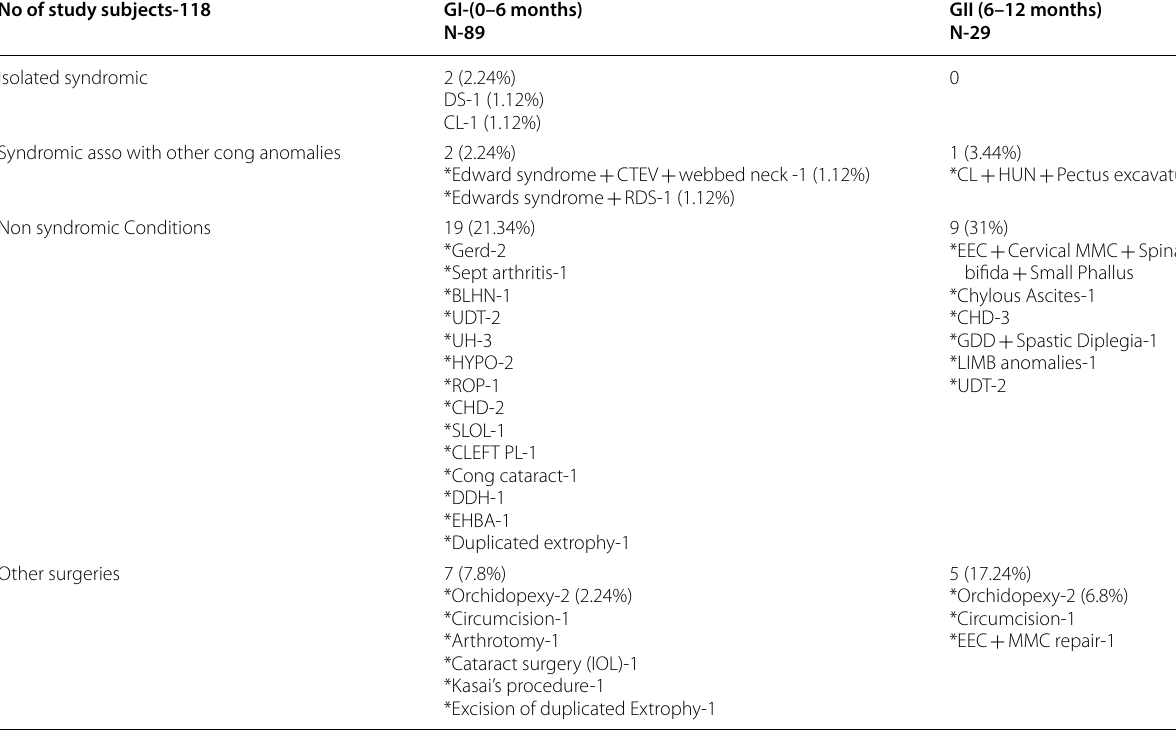
Table 2 Syndrome/conditions associated with infantile inguinal